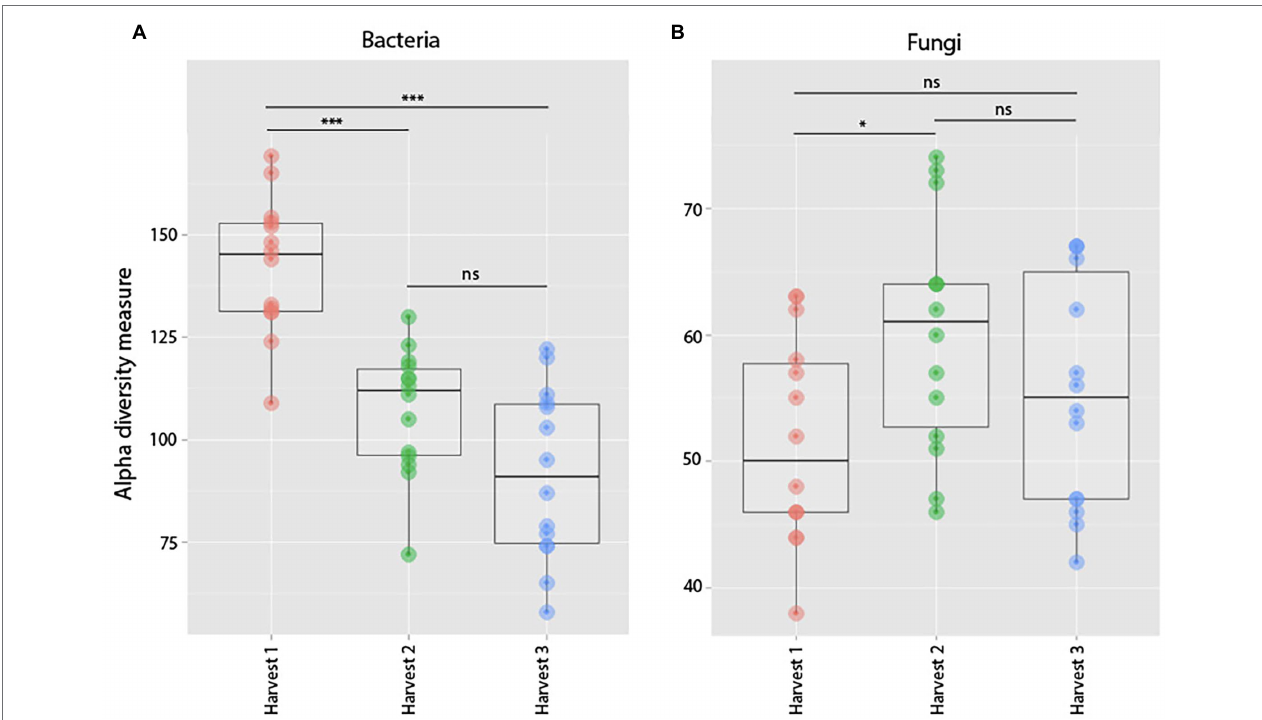
FIGURE 10 | Observed species richness of bacterial (A) and fungal (B) root communities among harvests. (Harvest 1 = 4 weeks. Harvest 2 = 5 weeks, and Harvest 3 = 12 weeks) that were exposed to resident soil exogenous soil. Bacterial richness decreased significantly between Harvests 1 and 2. For fungi, there was no significant change in richness between harvests. *** indicates p <